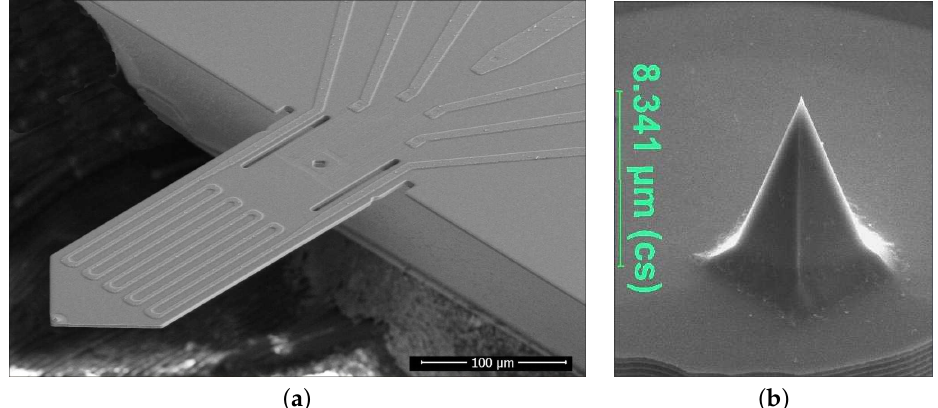
Figure 1. Magnification of the used self-sensing and self-actuated microcantilevers (courtesy of nano analytik GmbH, Ilmenau, Germany [16,17]). ( a ) SEM side-view image of the probe with integrated piezoresistive read-out and thermomechanical actuation (active cantilever). A sharp silicon tip ( b ) at the end of the cantilever ensures advanced AFM imaging and SPL capabilities [13]. These microcantilevers have dimensions of around 350µm in length, 120µm in width and 5µm in thickness